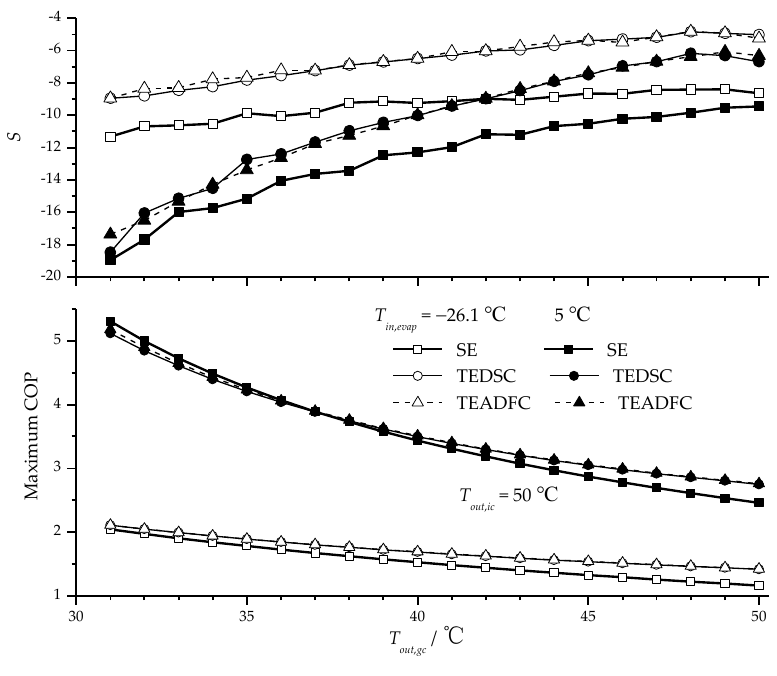
Figure 6. Sensitivity of maximum COP to temperature at gas cooler outlet.